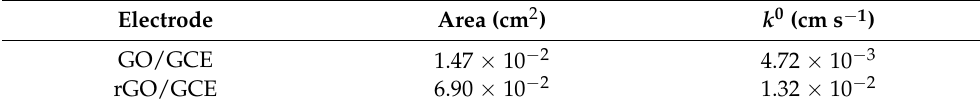
Table 1. Study of the electrochemically active area and k 0 .